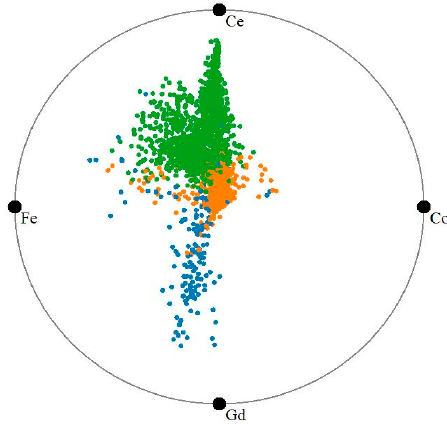
Figure 1. The battery dataset visualized with RadViz.